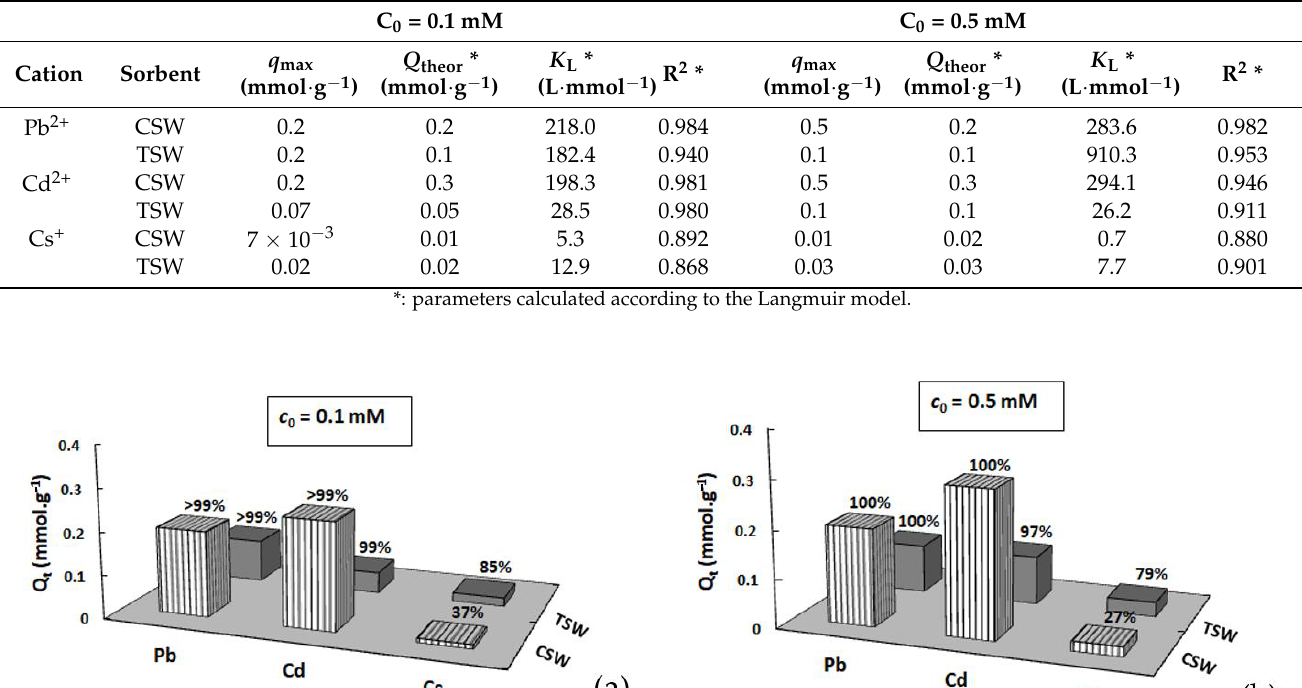
Table 2. Adsorption parameters for Pb 2+ , Cd 2+ and Cs + adsorption on CSW and TSW.